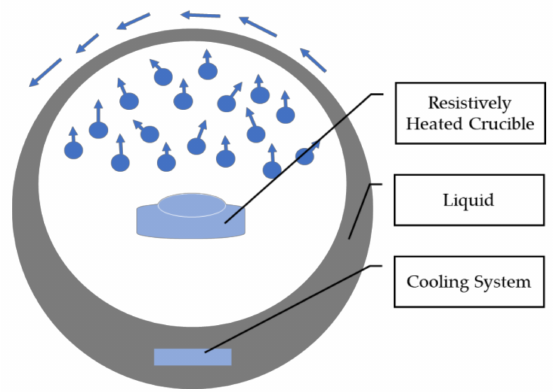
Figure 3. Schematic diagram of vapor deposition